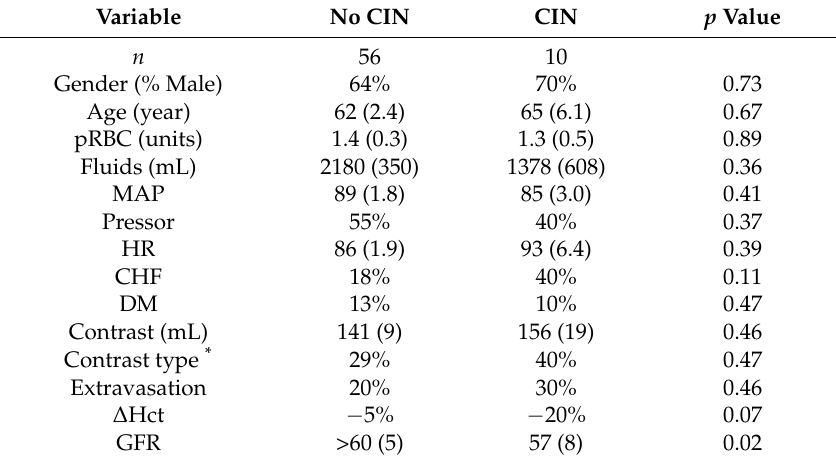
Table 3. Comparison of patients who developed contrast-induced nephropathy (CIN) to those who did not. Variable No CIN